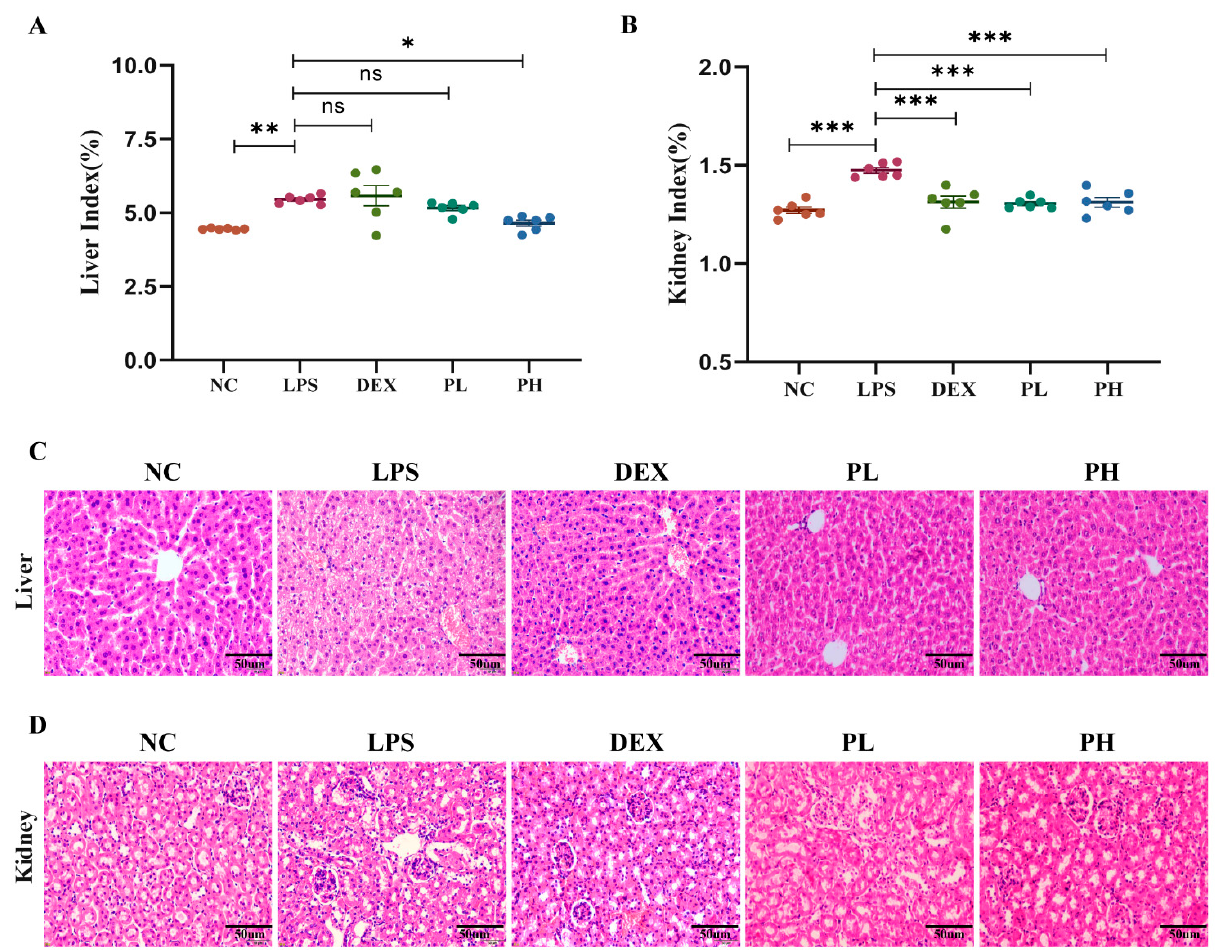
Figure 7. Pectolinarin alleviates LPS-induced liver and kidney histopathologic injury in mice. ( A ) Liver index. ( B ) Kidney index. ( C , D ) Representative histopathologic sections of liver and kidney tissue stained with H&E. Data are presented as mean ± SD (n = 6~8). * p < 0.05, ** p < 0.01, and *** p < 0.001, compared with LPS group. The kidney and liver indexes are calculated utilizing the following formula: kidney or liver weight/mouse body weight × 100%. NC, normal control group; LPS, lipopolysaccharides challenged (5 mg/kg) group; DEX, lipopolysaccharides-challenged and dexamethasone (10 mg/kg)-treated group; PL, lipopolysaccharides-challenged and low dose of pectolinarin (25 mg/kg)-treated group; PH, lipopolysaccharides-challenged and high dose of pectolinarin (50 mg/kg)-treated group. ns: not